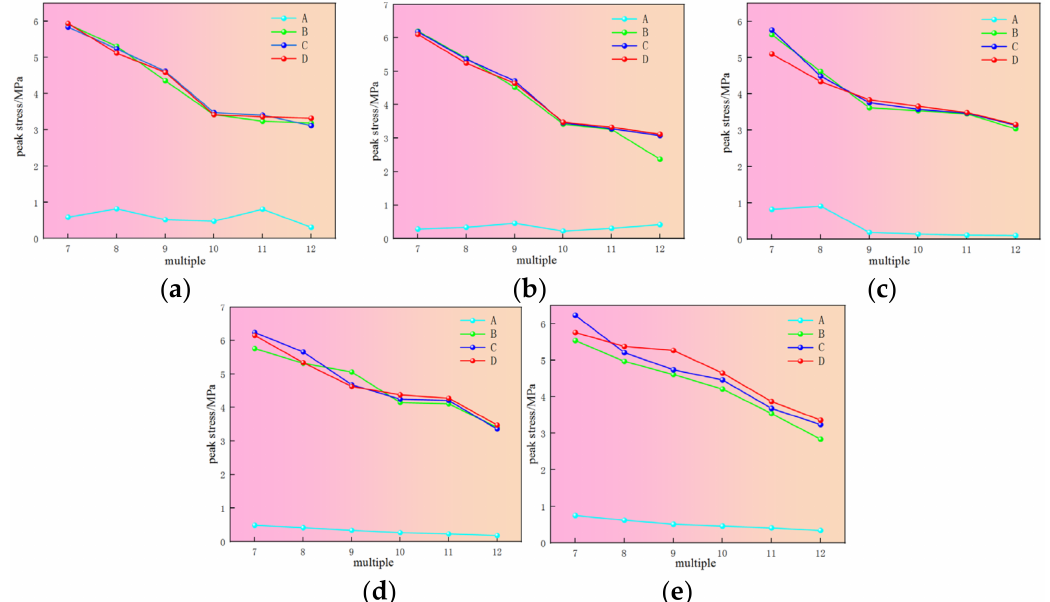
Figure 15. Y-direction peak stress curve at observation point. ( a ) 90 mm aperture. ( b ) 100 mm aperture. ( c ) 110 mm aperture. ( d ) 120 mm aperture. ( e ) 130 mm